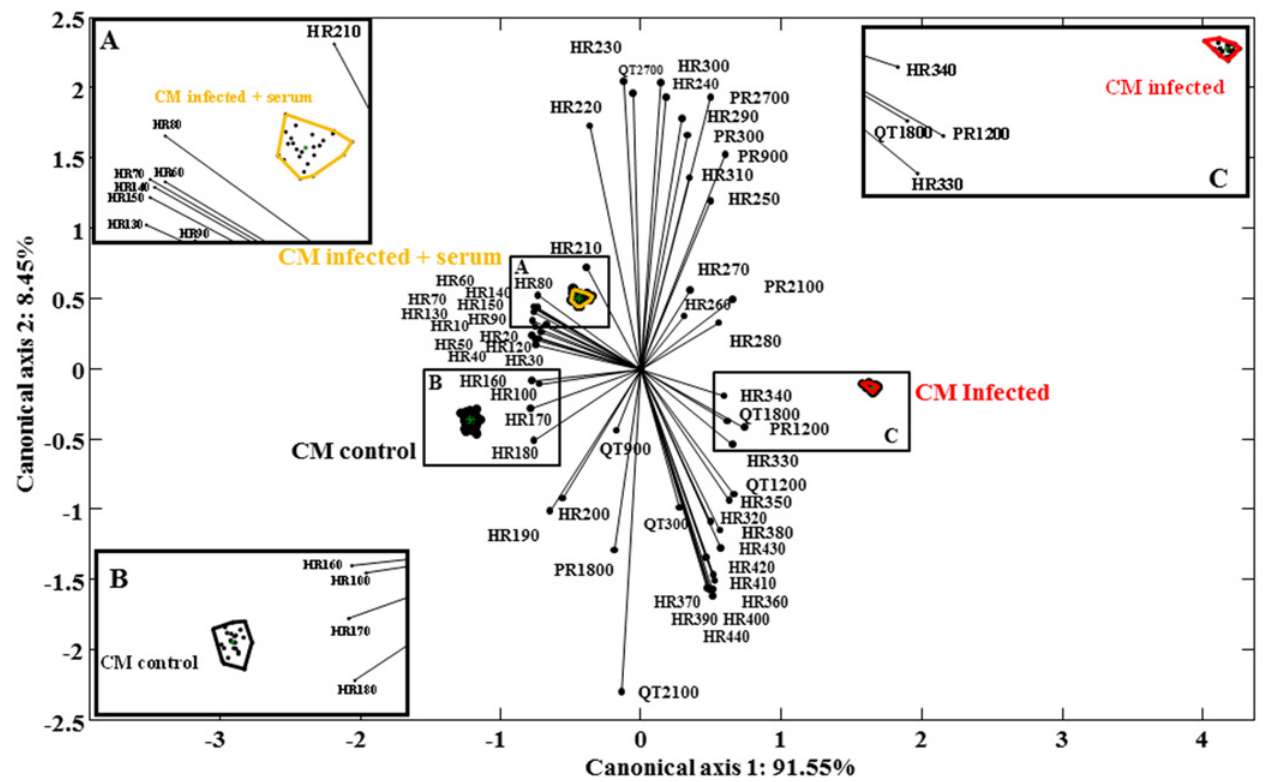
Fig 5. Canonical Biplot of the measured in three perfusion conditions. Comparing QT interval, PR interval, and heart rate in time. The axis 1 explain 91.55% and the axis 2 explain 8.45% of the variance with a Global contrast based on Wilk ’ s Lambda of 132.0474 and a p-value of 4.3475e-31. With the three (A, B & C) amplified regions we showed the convex hulls of the three groups and the calculated centroid. Due to scale differences between variables, each one were standardize separately. Analysis carried out with MULTBIPLOT